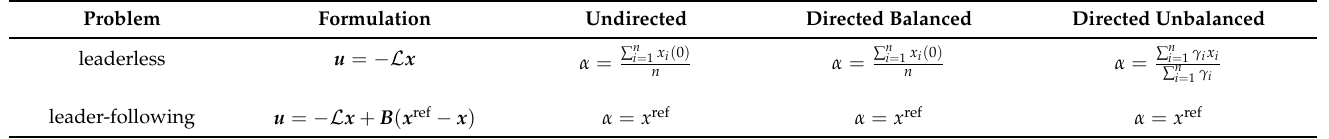
Table 3. Summary of the leaderless and leader-following consensus formulations in continuous-time